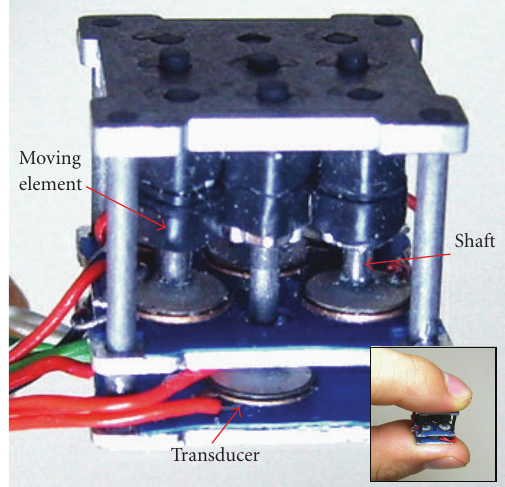
Figure 2: The implemented tactile display module.